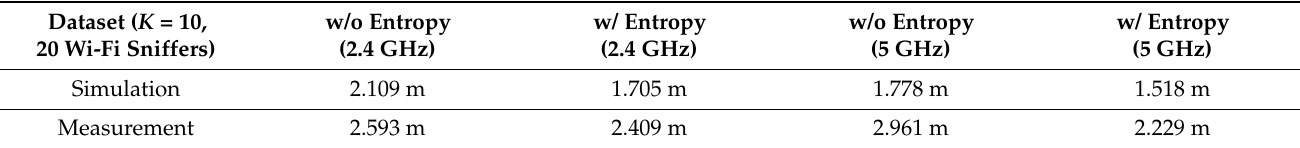
Table 2. RMSE for simulation and measurement data (20 Wi-Fi